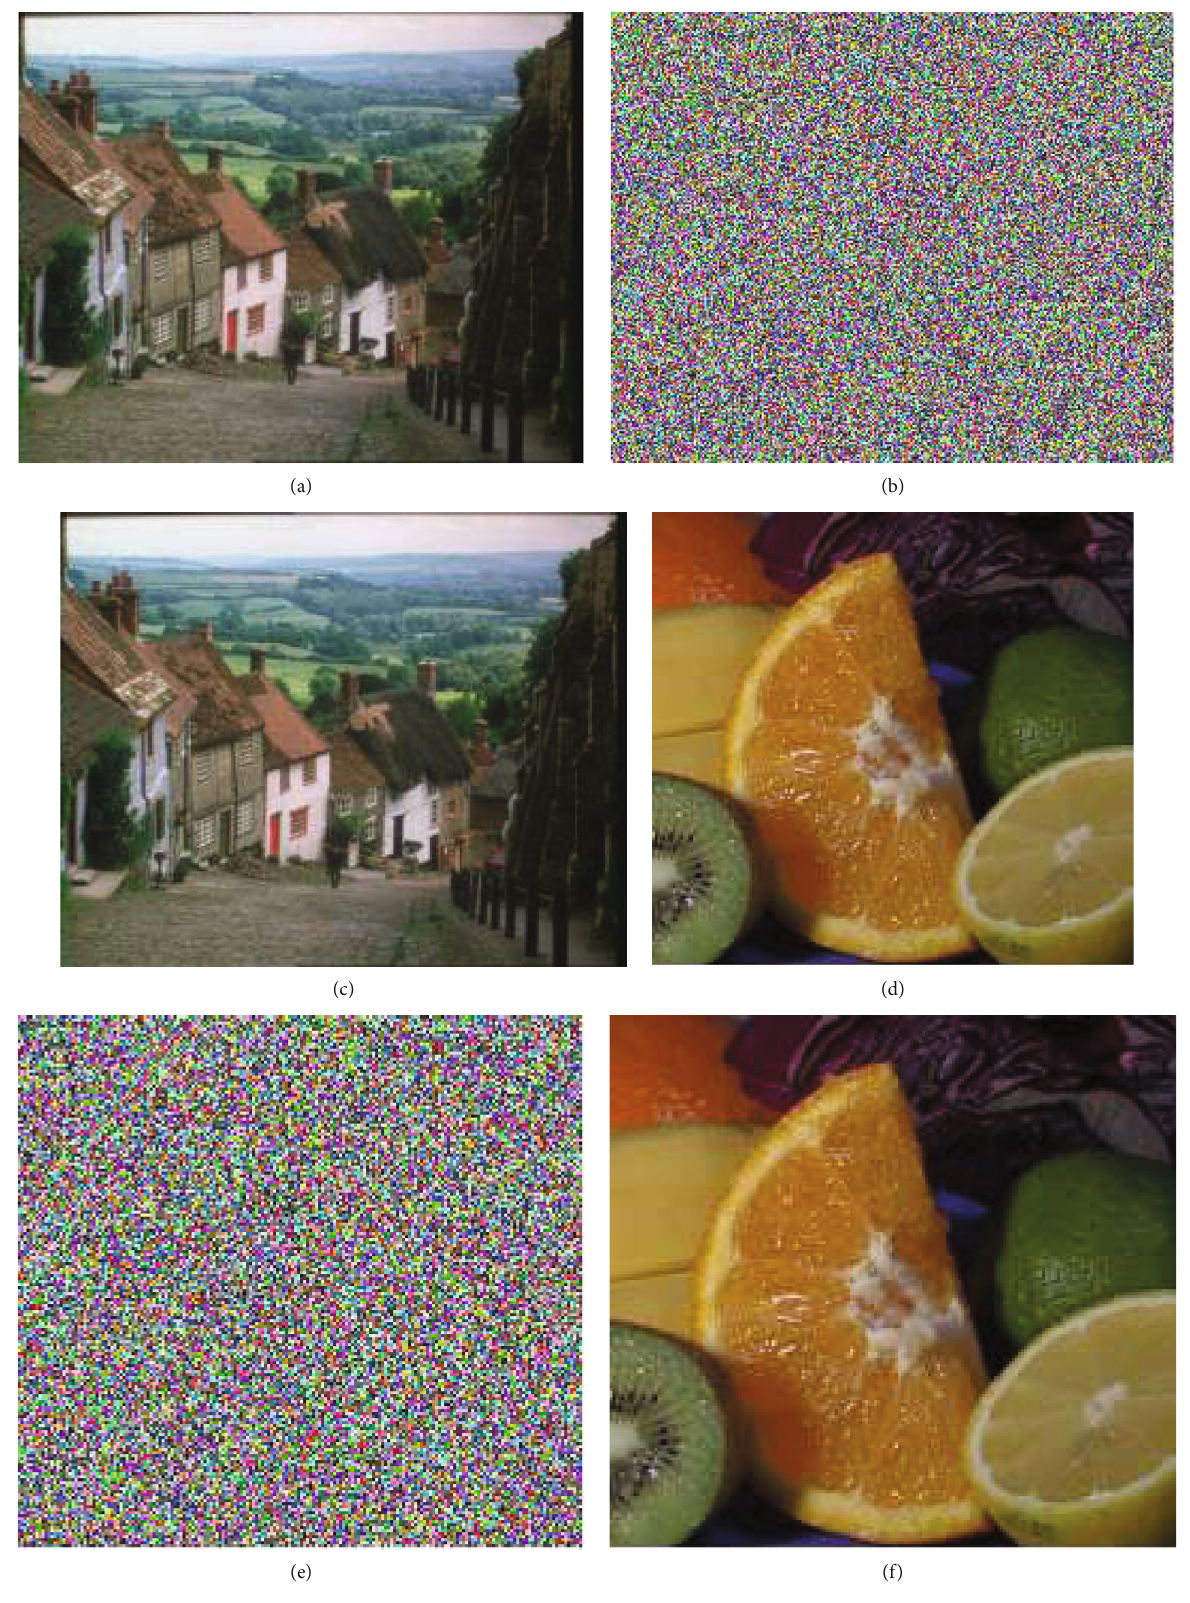
Figure 4: Encryption and decryption of Goldhill and Fruits. (a) Plaintext of Goldhill. (b) Ciphertext of Goldhill. (c) Decryption of Goldhill. (d) Plaintext of Fruits. (e) Ciphertext of Fruits. (f) Decryption of